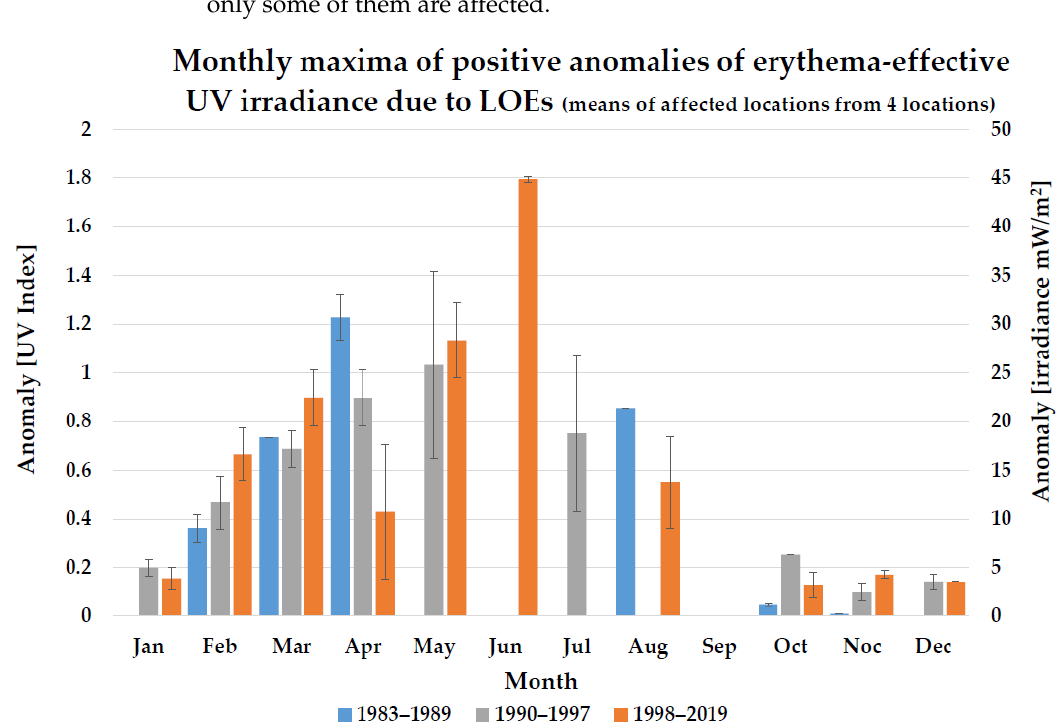
Figure 8. Monthly maxima of the positive anomalies of the erythema-effective UV irradiance and equivalent UV index associated with LOEs during the subperiods T1 (1983–1989), T2 (1990–1997), T3 (1998–2019) (means of affected locations from 4 locations and standard deviations).